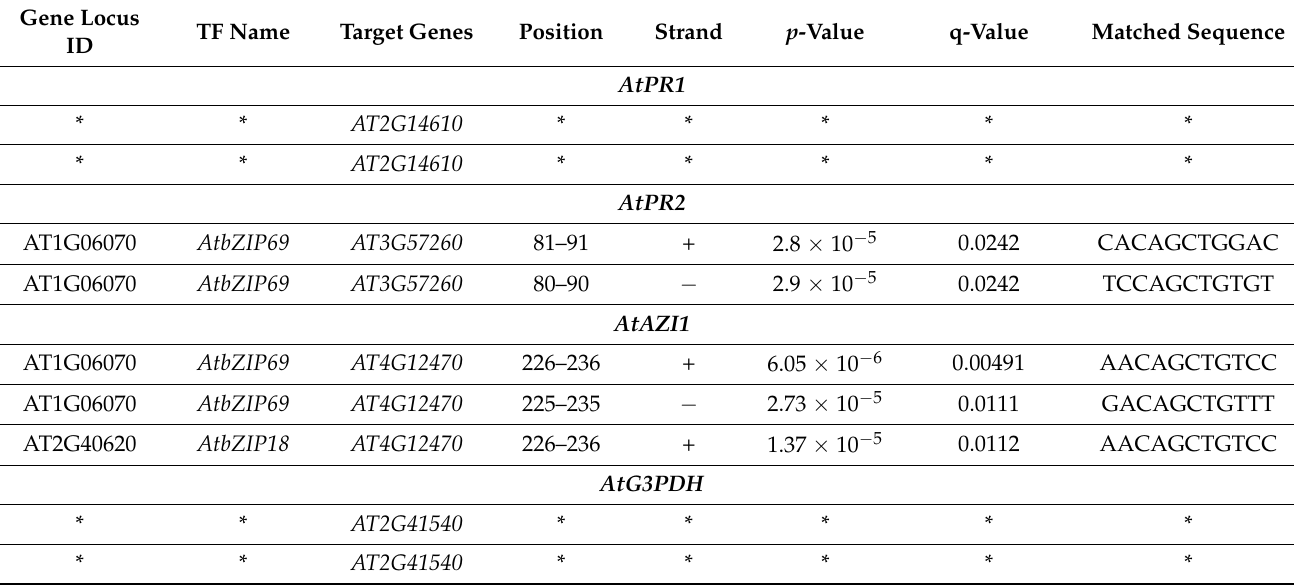
Table 1. Identified transcription factor binding sites in the promoter of target